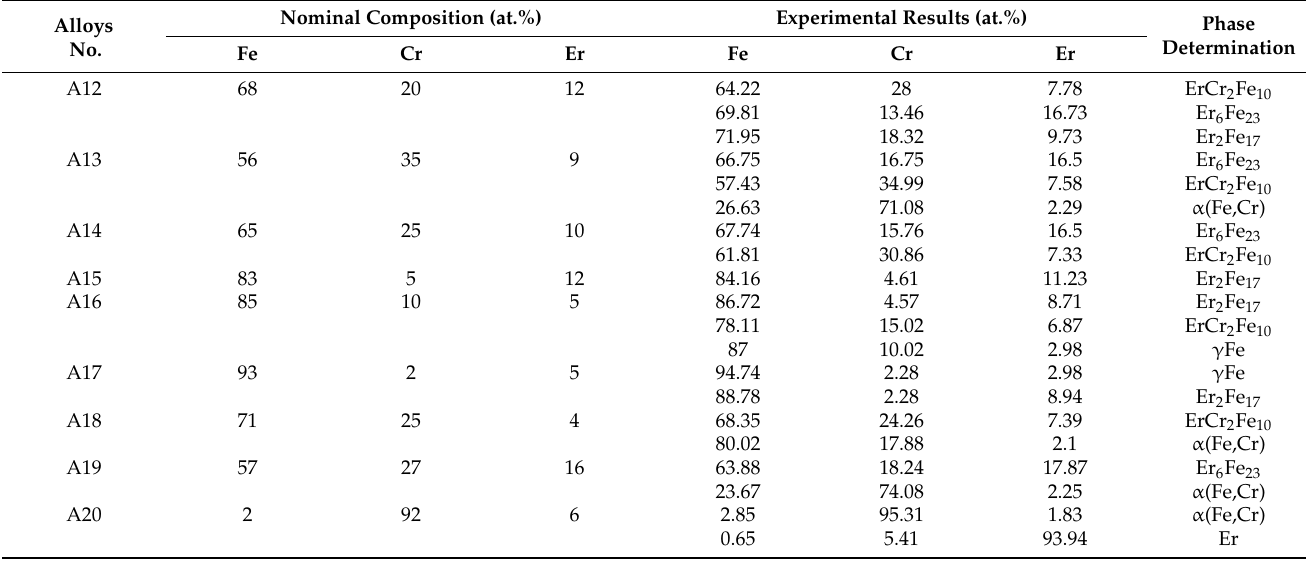
Table 3. Constituent phases and compositions in the annealed Fe–Cr–Er alloys at 1073 K for 90 days. Alloys